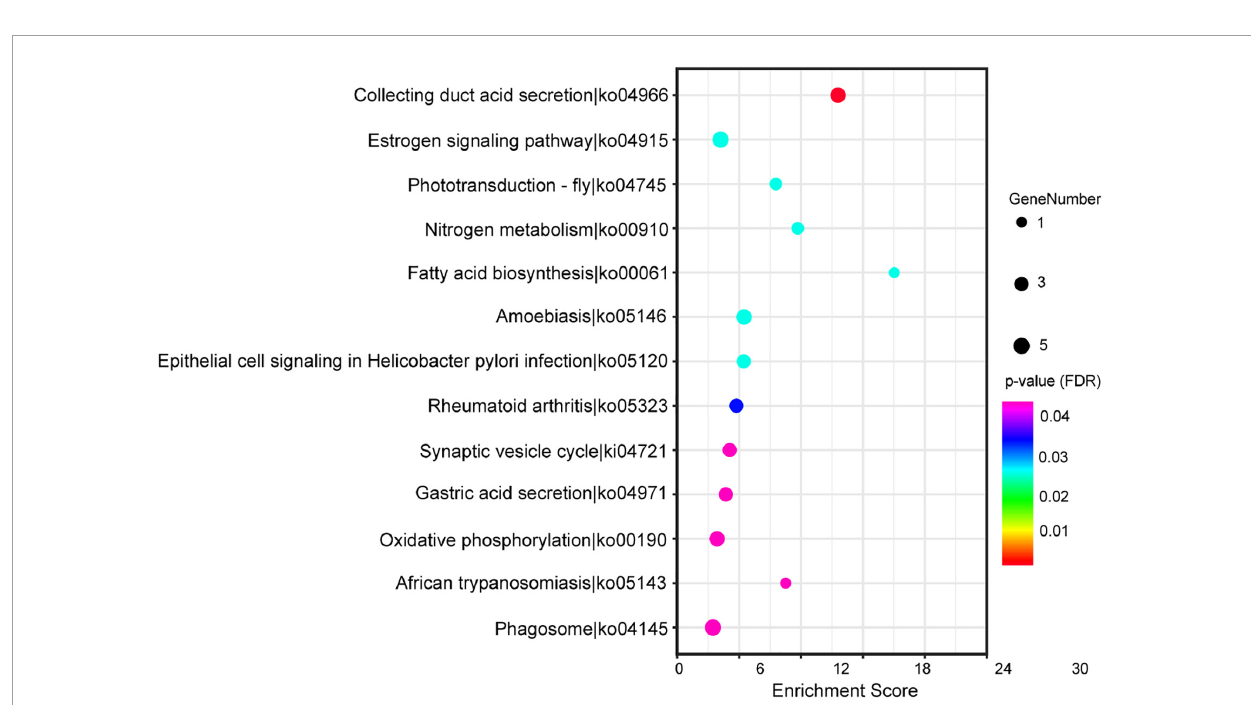
FIGURE4 The top 20 of the Kyoto Encyclopedia of Genes and Genomes (KEGG) pathways significantly enriched in differentially expressed genes (DEGs). The horizontal and vertical axis showed the enrichment scores of DEGs and the specific pathways, respectively. The color of each dot represented the corrected p -value for the corresponding pathway, and the dot size indicated the number of the DEGs associated with each corresponding pathway.